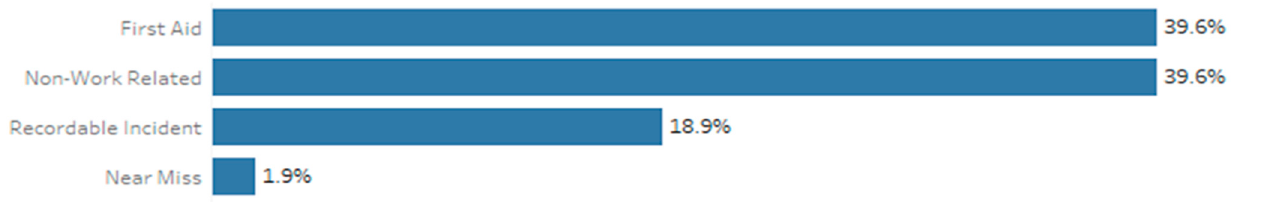
Table 1. Contingency table of insurance records and IMS classifications.